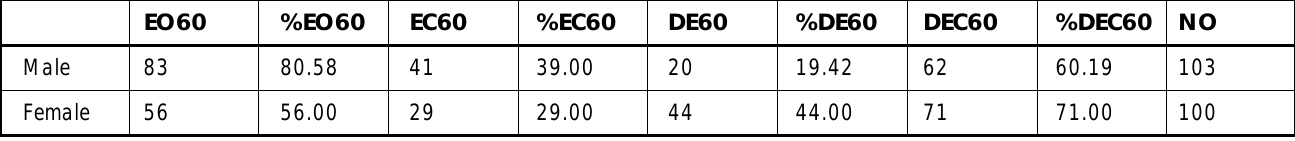
Table 1: Performance of subject in sharpened.